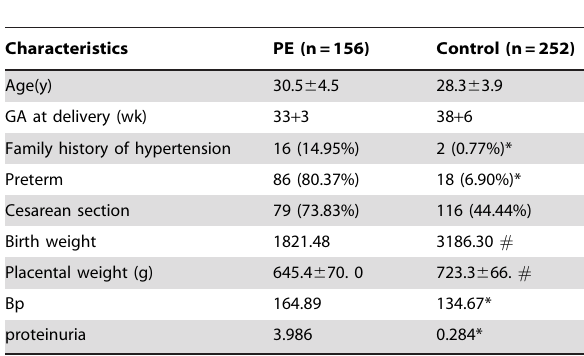
Table 1. Demographic and clinic-pathological characteristics of subjects (Mean 6 SD).